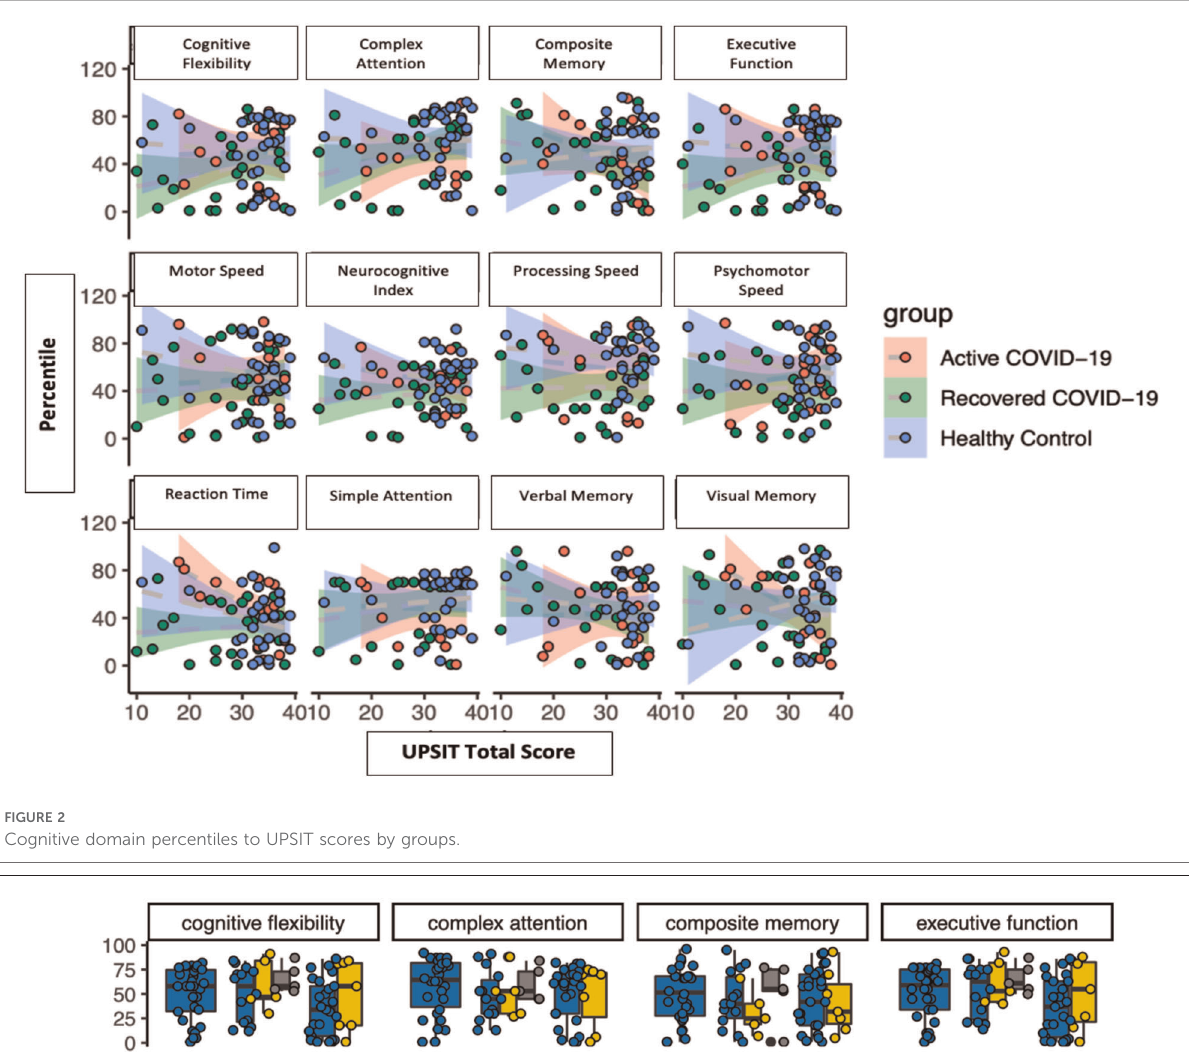
FIGURE 2 Cognitive domain percentiles to UPSIT scores by groups.